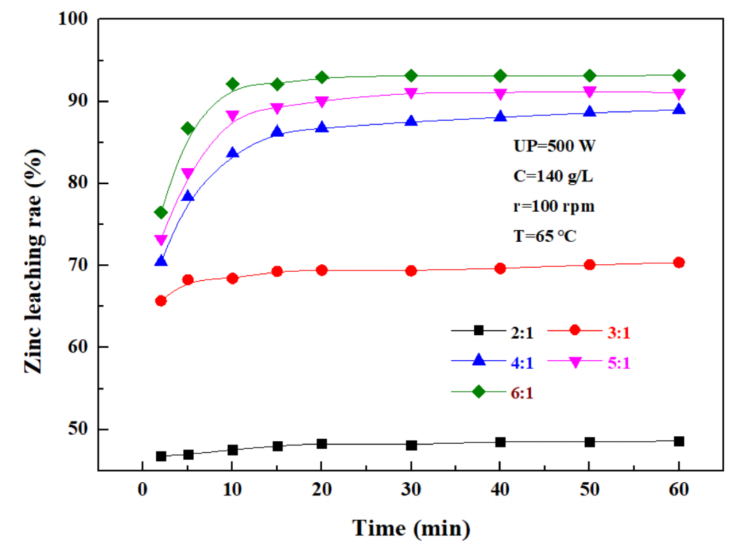
Figure 8. Effect of liquid–solid ratio on zinc leaching